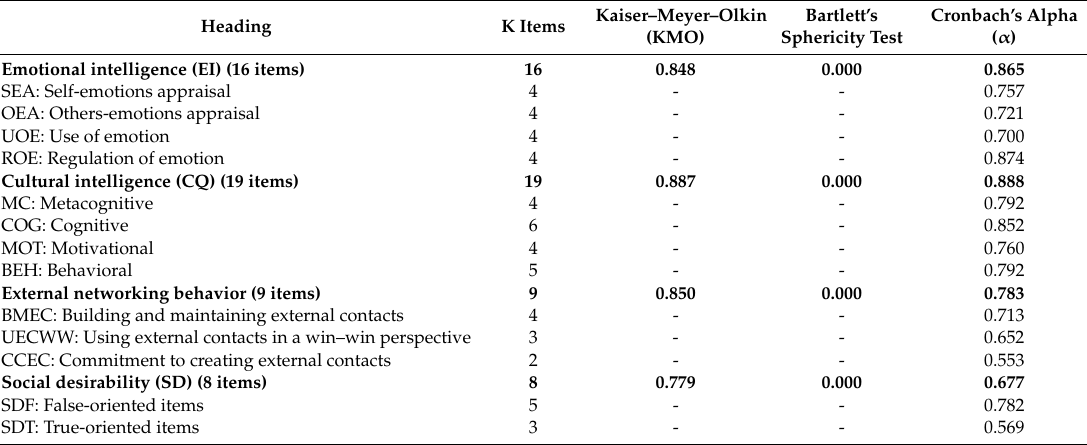
Table 3. Exploratory factor analysis report (EI, CQ, ENB, and SD). Heading